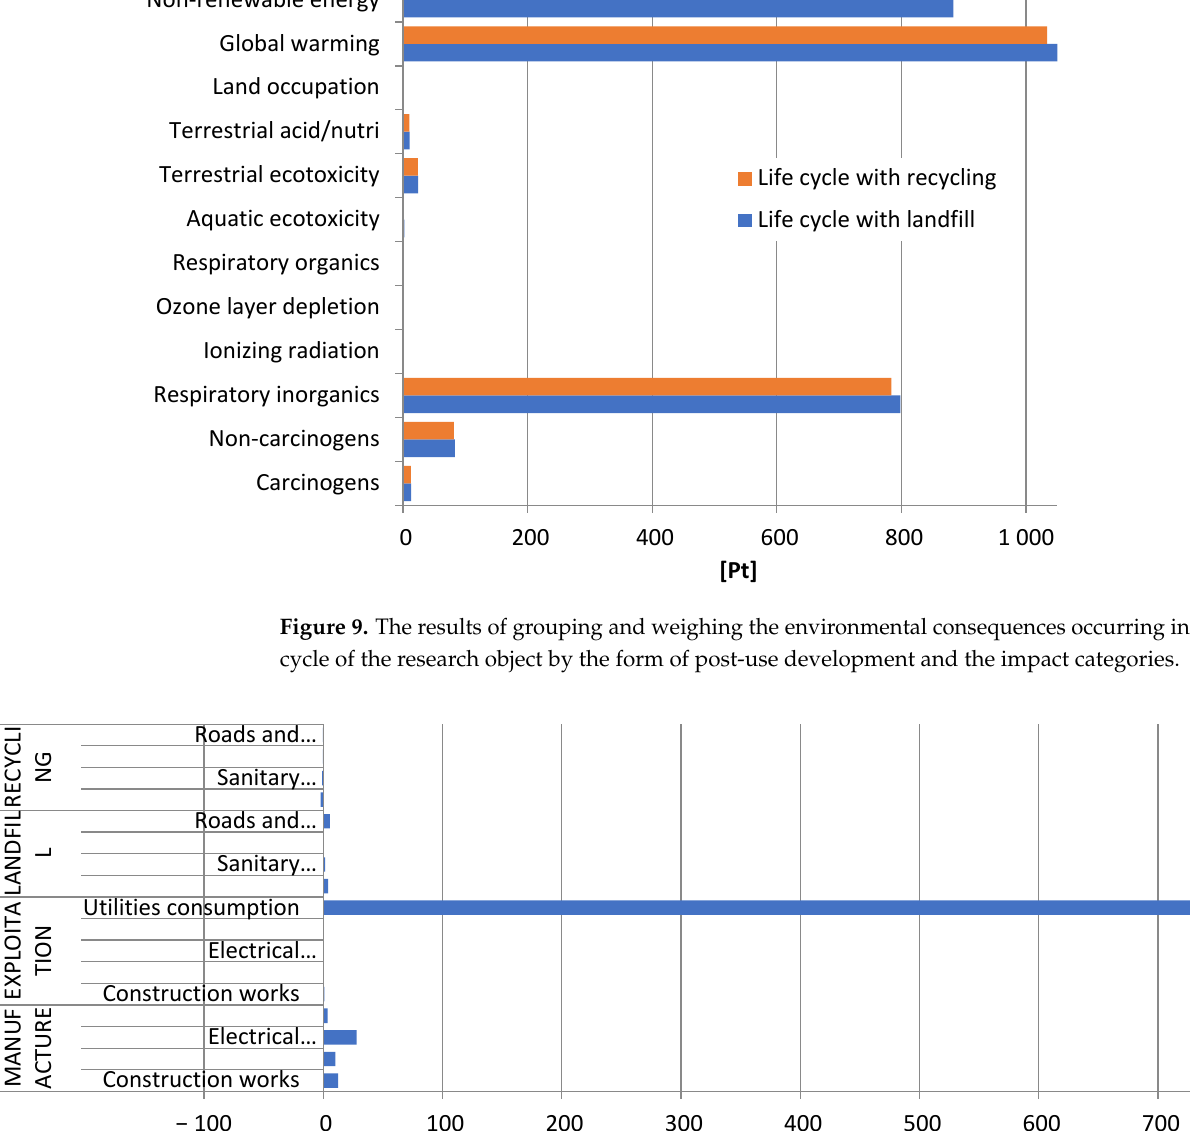
Figure 10. Results of grouping and weighing the environmental consequences of emissions of compounds causing global warming occurring in the life cycle of the research object.